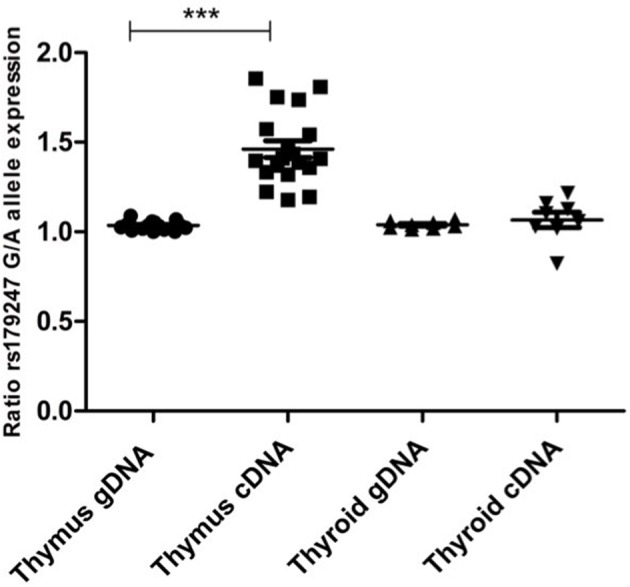
Preferential transcription of the rs179247 GD protective allele in the thymus. We used massive parallel sequencing to determine the relative abundance of TSHR alleles in 19 thymus and 8 thyroid cDNA samples from individuals heterozygous for the GD-associated SNP, rs179247. Specific primers were designed for the intron 1 region of the TSHR gene containing the analyzed SNP. Allele-specific quantification was measured in the gDNA, as a control for equal biallelic representation, and the cDNA in all samples. Each point represents the ratio between the G (protecting) and the A (predisposing) allele reads. ***p < 0.001 using a Kruskal Wallis test with Dunn's multiple comparison test.